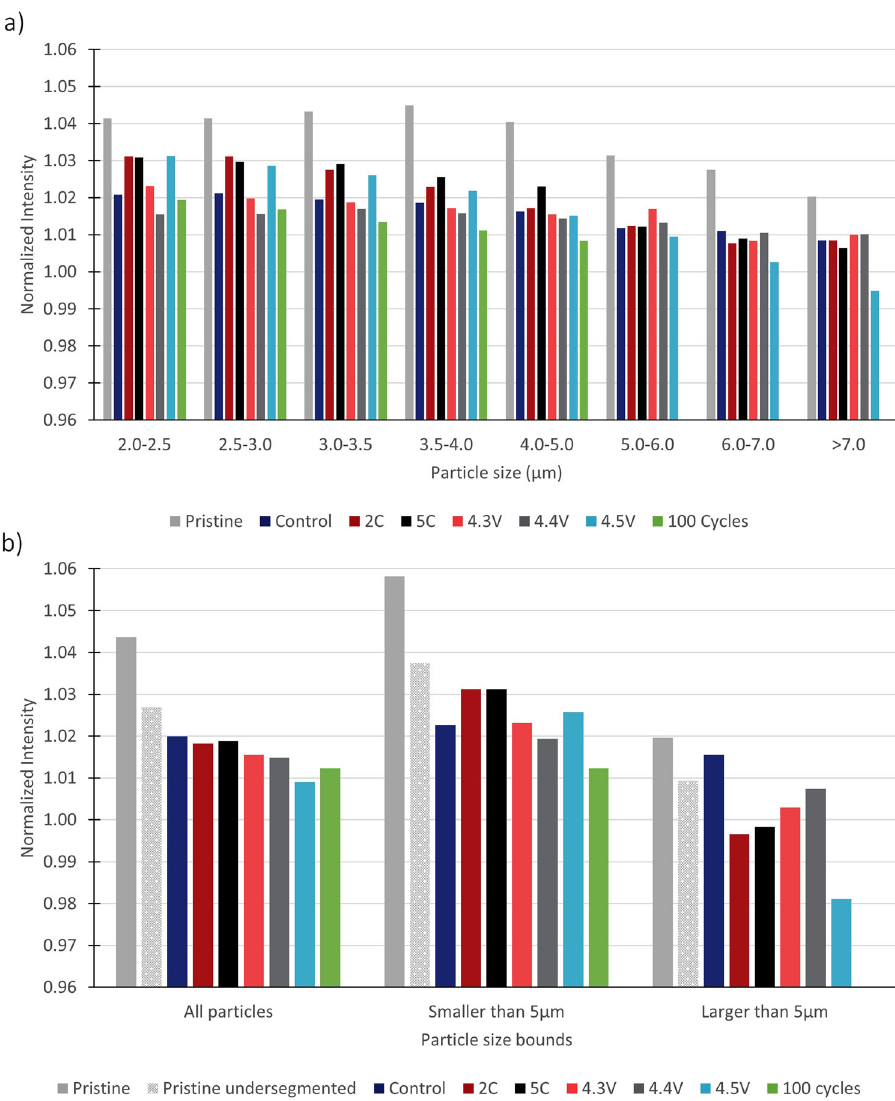
Fig. 7 Average and fi nal intensities for all samples. a Average normalized intensities for each particle bound and b core normalized intensity including the undersgmented pristine sample for